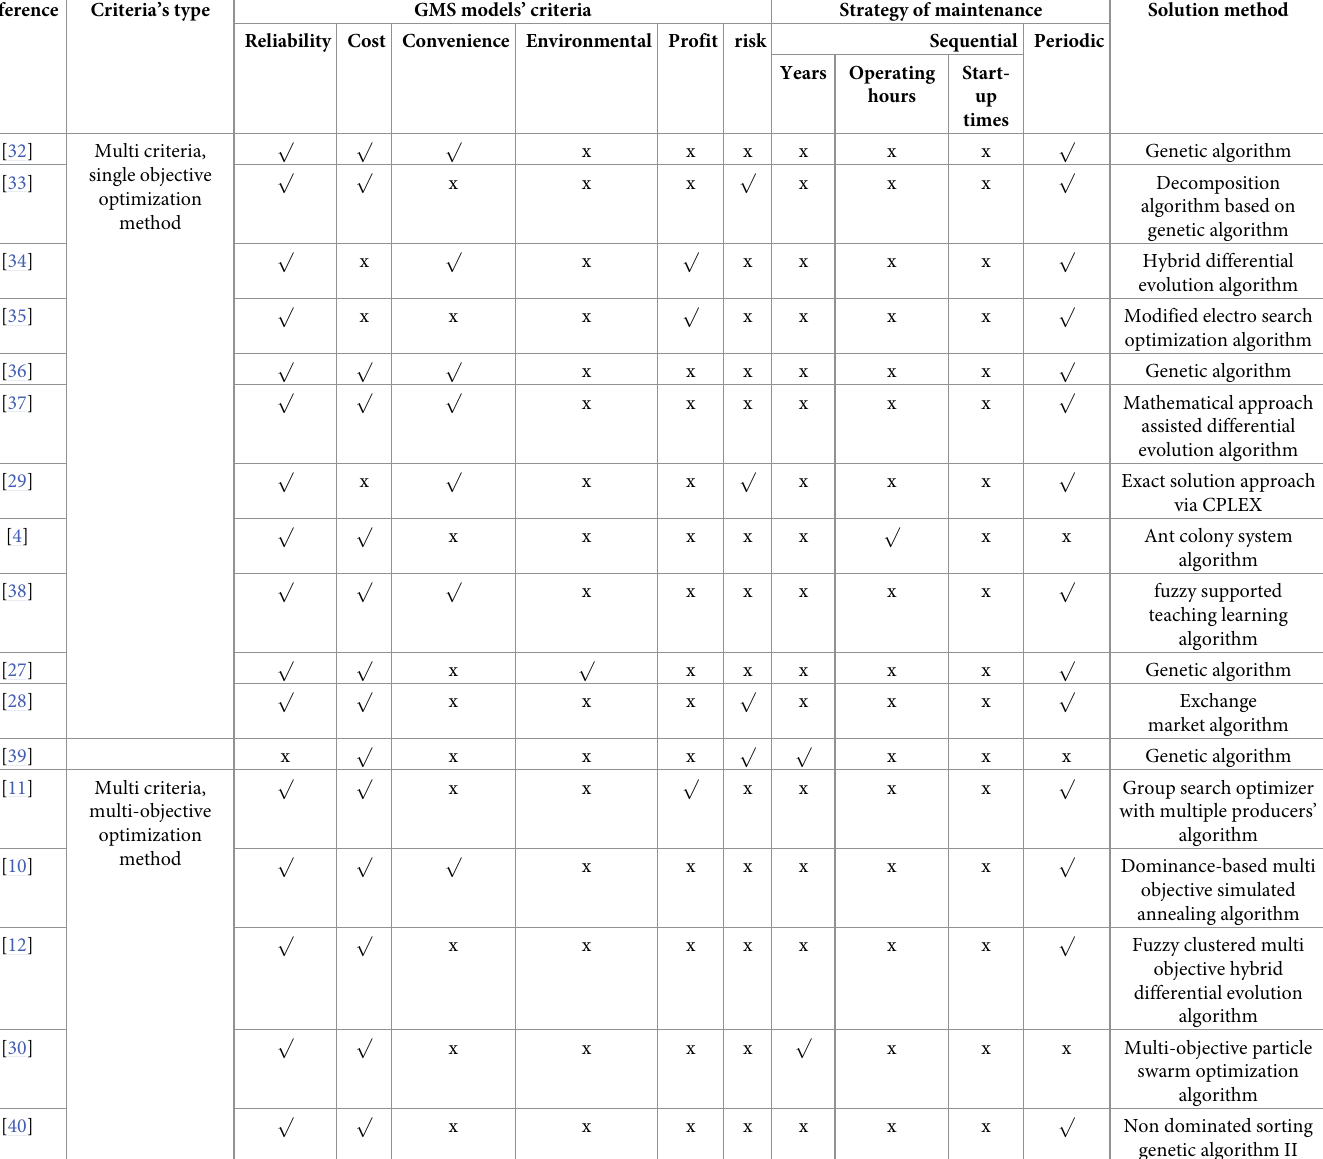
Table 1. GMS models and solution